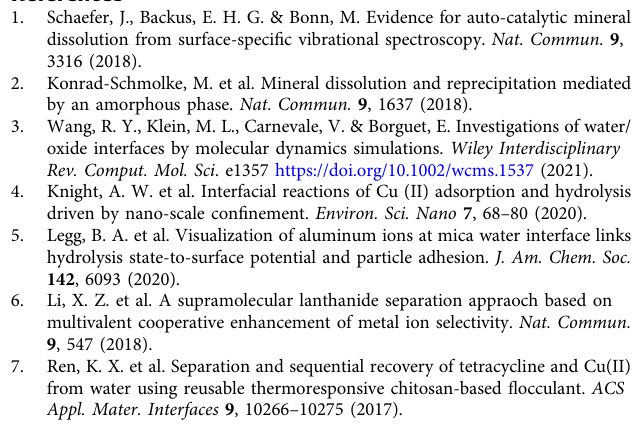
Fig. 4 Cluster-based free energy pro fi les associated with (Cu 2 + ) 2 (OH − ) 2 (H 2 O) p . Red circles denote cluster dimerization free energies ( Δ G ð g Þ associated with structures A – D, where p = 4, 5, 6, and 8; implicit PCM solvent is also applied. D is taken from a snapshot of AIMD simulations and further optimized. B ’ (blue circle) also has p = 5; but one of the H 2 O is coordinated to OH − and neither of the Cu atoms. Green diamonds have con fi gurations similar to those for red circles, but PCM is not used. Dashed lines are guides to the